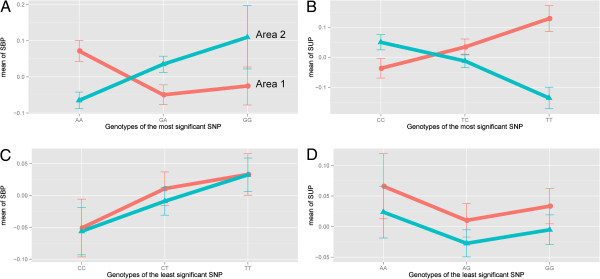
Locus-specific analysis of the norm of reaction. The norm of reaction was observed for the most significant loci of the genotype-environment interaction from association studies for both traits (A and B), whereas the parallel shape was seen for the least significant loci of both traits (C and D).